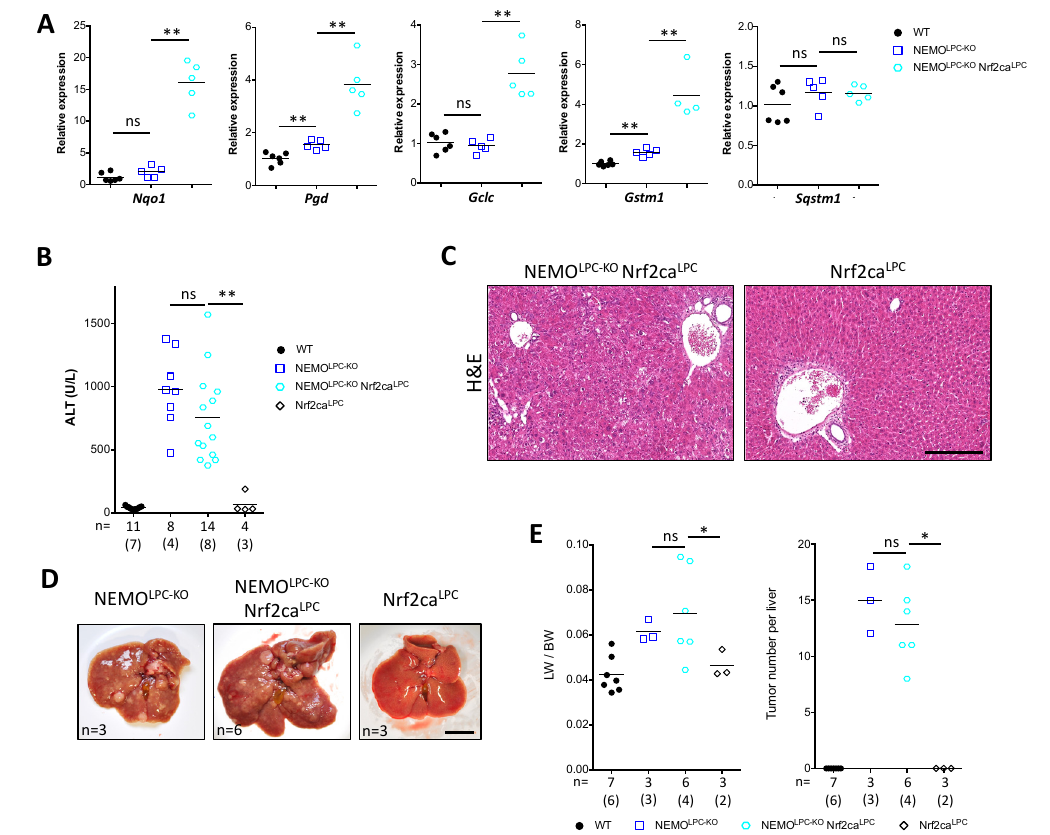
Figure 6. LPC-specific Nrf2ca expression does not alter liver damage and hepatocarcinogenesis in NEMO LPC-KO mice. ( A ) Expression of Sqstm1 and Nrf2 target genes quantified by qRT-PCR on liver samples with the indicated genotypes. Relative expression normalized to Ppia expression is presented and compared to age-matched WT control samples ( n = 5–6). ( B ) Serum ALT levels in 8-week-old mice with the indicated genotypes. Each symbol represents one mouse and horizontal lines indicate mean values ( n = 4–19 mice). ( C ) Representative images of H & E-stained liver sections from 8-week-old mice with the indicated genotypes. ( D , E ) Representative liver images ( D ), LW/BW ratio and tumor number per liver ( E ) in 1-year-old mice with the indicated genotypes. In B and E, n indicates the number of analyzed mice, out of which the number of males is shown in brackets. ns, not significant; * p ≤ 0.05, ** p ≤ 0.01. Bars: 200 µm ( C ), 1cm ( D ).